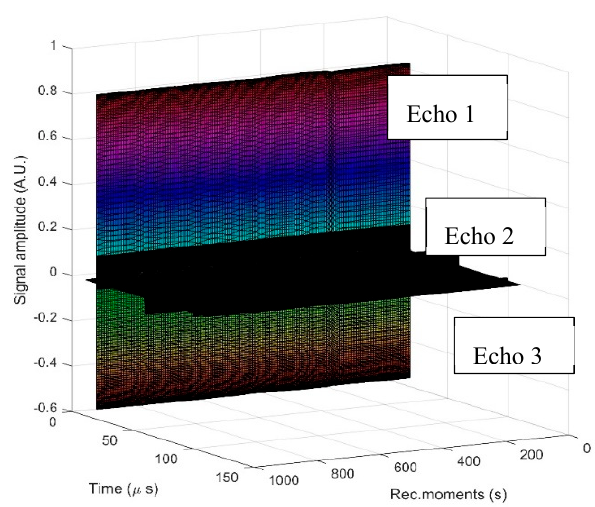
Figure 2. Recorded T signals during 1000 s. Each signal includes three echoes.